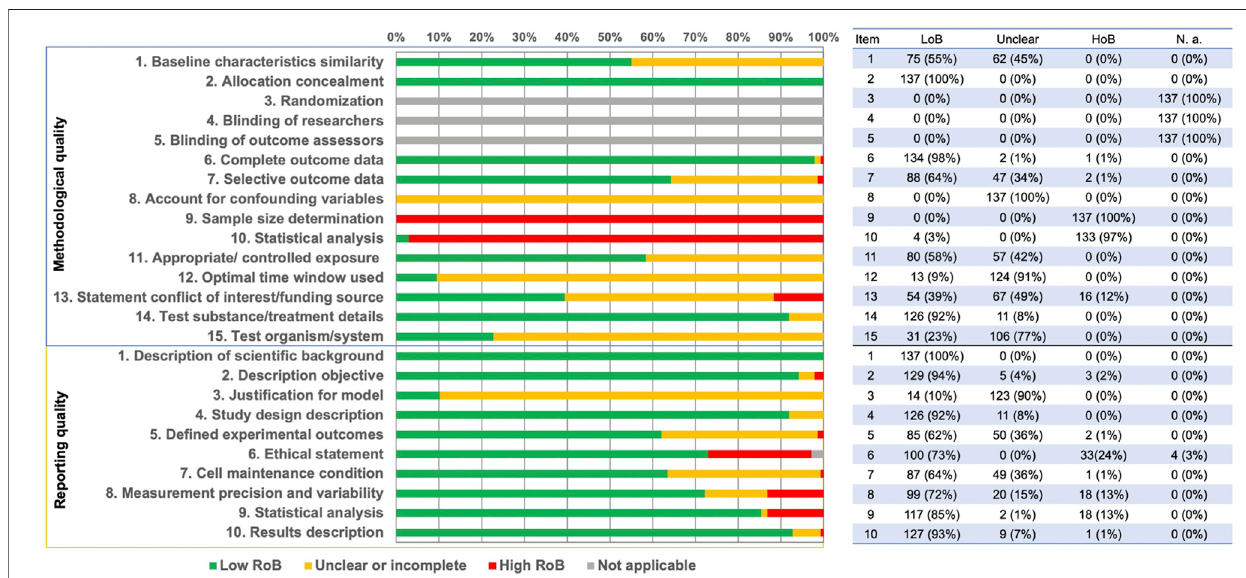
FIGURE4| Summaryoftheriskofbiasassessmentsformethodological(upperpanel)andreportingqualityriskofbias(lowerpanel).Thetabulateddataontheright reported frequency and percentage [n(%)] for each item according to its scoring: “ LoB ” – low risk of bias, “ Unclear ” – unclear or incomplete, “ HoB ” – high risk of bias, “ N.a. ” – not applicable.